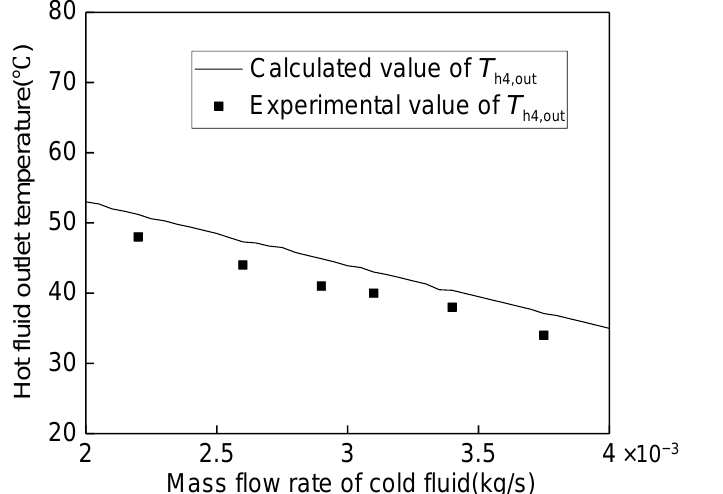
Figure 10. Experimental verification of the hot fluid outlet temperature of the four-stage condensers. At the same time, when the mass flow rate of the cold fluid of each stage condenser was 3 × 10 − 3 kg/s, the yield range of the liquid product of each stage condenser was obtained, as shown in Figure 11. It can be seen that the yield of the first-stage condenser was the highest and had the largest fluctuation range and yields of the subsequent condensers decreased sequentially. The reason was also that the first-stage condenser, as the main place for the heat exchange of hot and cold fluids, must have the most condensed products. The gradual decrease in the fluctuation range was likely to be caused by the liquefaction of water steam. The above results demonstrated the importance of the first-stage condenser, and its liquid product yield was higher than the literature results [12,27].